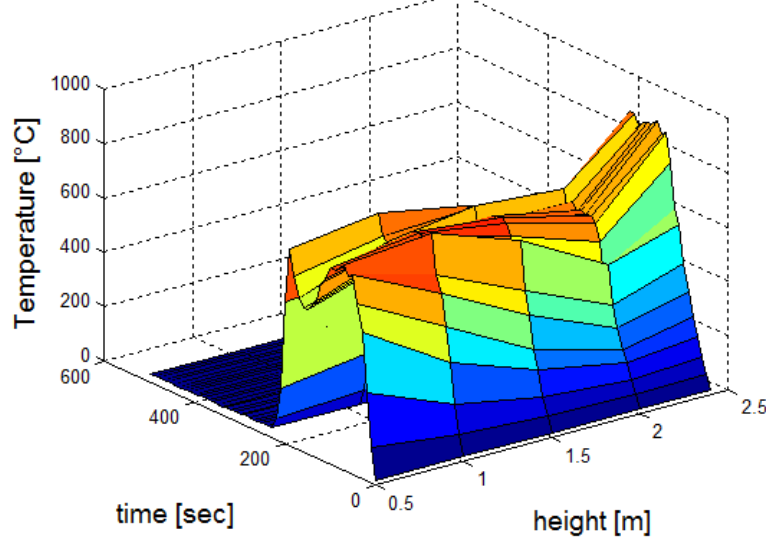
Figure 22. Three dimensional plot of the temperature field as a function of time and height.